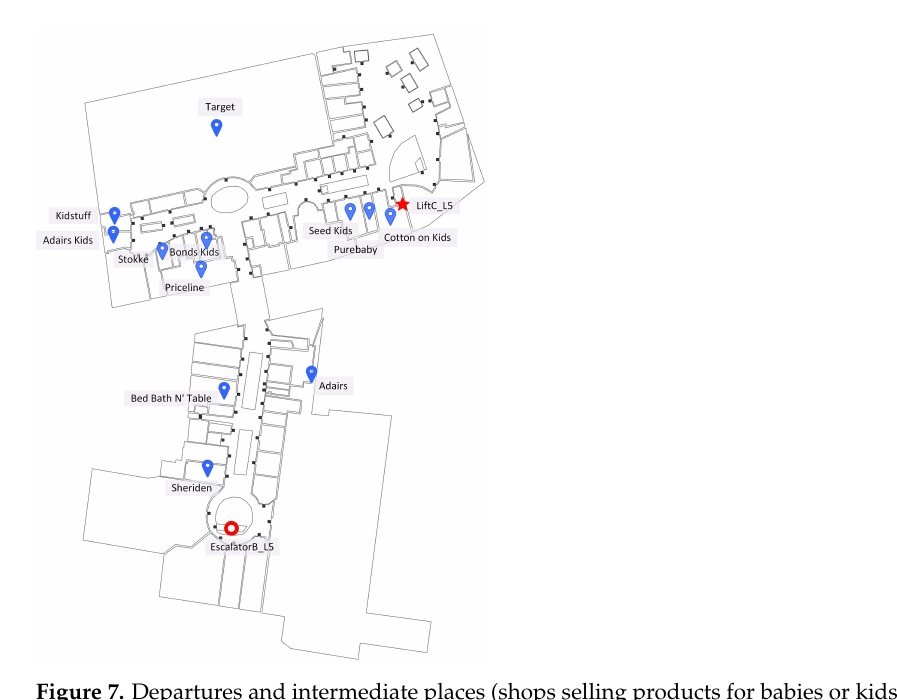
Figure 7. Departures and intermediate places (shops selling products for babies or